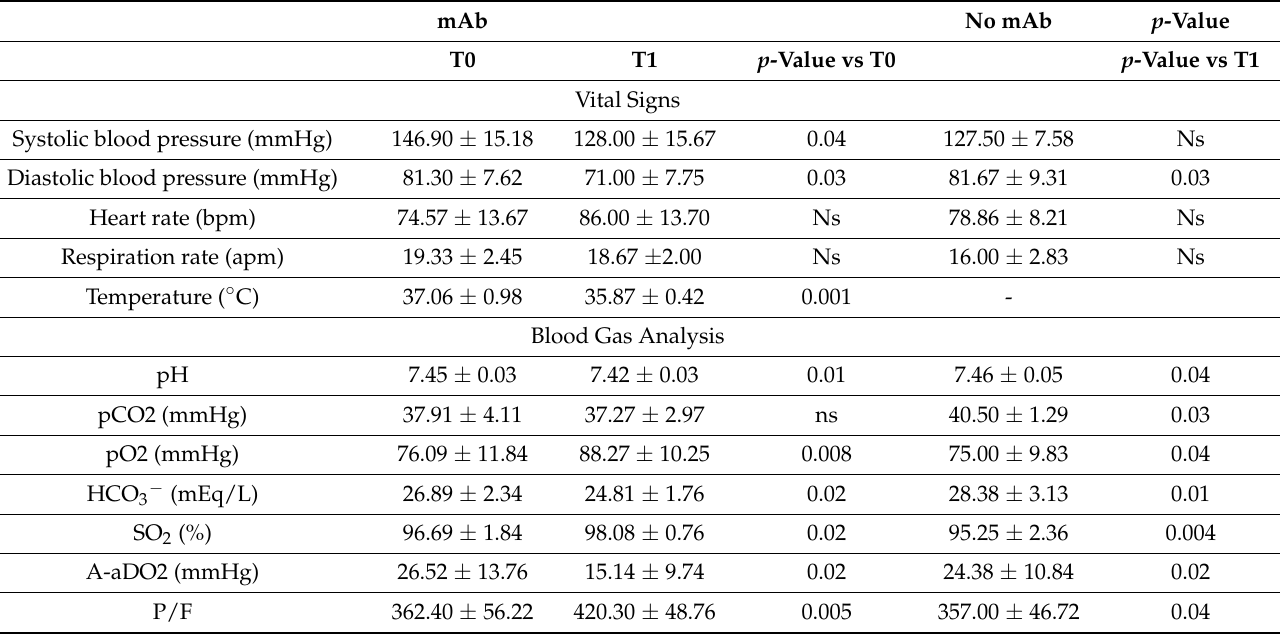
Table 3. Group 1 (mAb) and Group 2 (No mAb) vital signs and blood gas analysis at diagnosis of SARS-CoV-2 infection (T0) and after 3 months (T1). mAb No mAb p -Value T0 T1 p -Value vs T0 p -Value vs T1 Vital Signs 146.90 ±